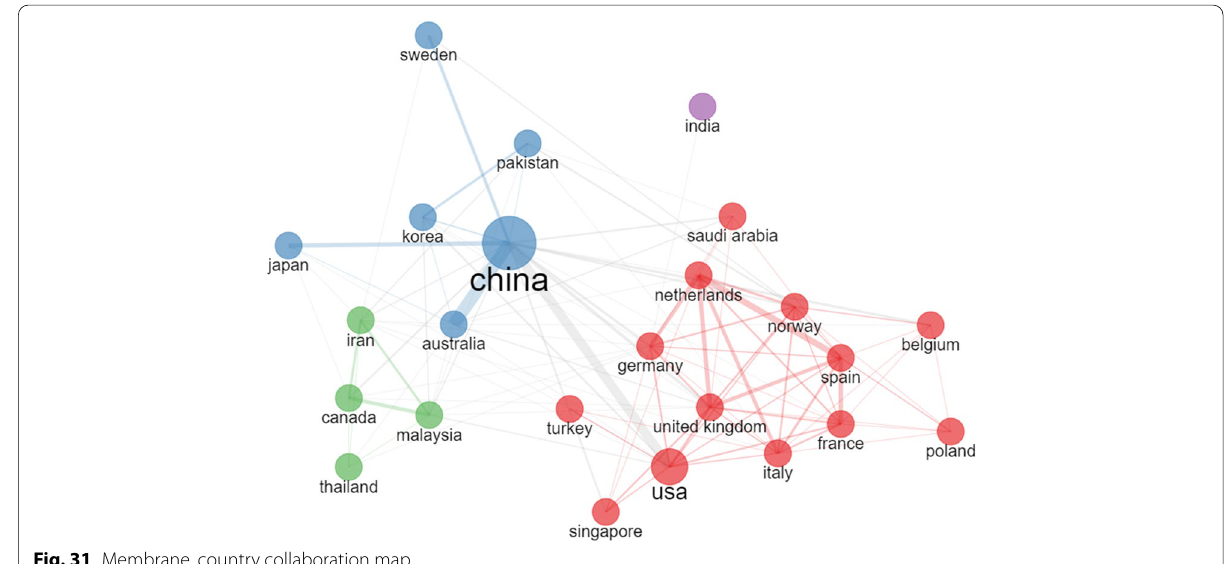
Fig. 31 Membrane, country collaboration map